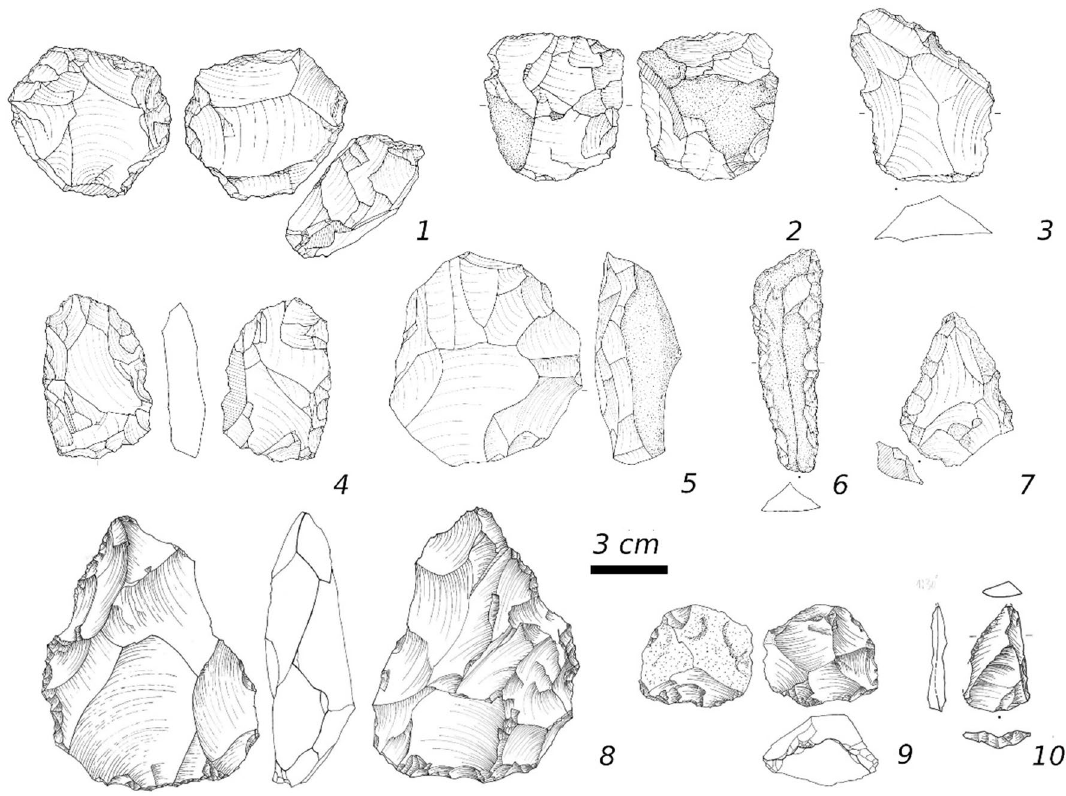
Figure 3. Examples of stone artifacts from AH V ( 1 – 3 ), AH VI ( 4 – 7 ) and AH VII ( 8 – 10 ). ( 1 ) inversely retouched scraper, ( 2 ) unidirectional Levallois core, ( 3 ) sidescraper, ( 4 ) bifacial artifact, ( 5 ) centripetal Levallois core, ( 6 ) retouched blade, ( 7 ) point, ( 8 ) bifacial artifact, ( 9 ) centripetal Levallois core, ( 10 )